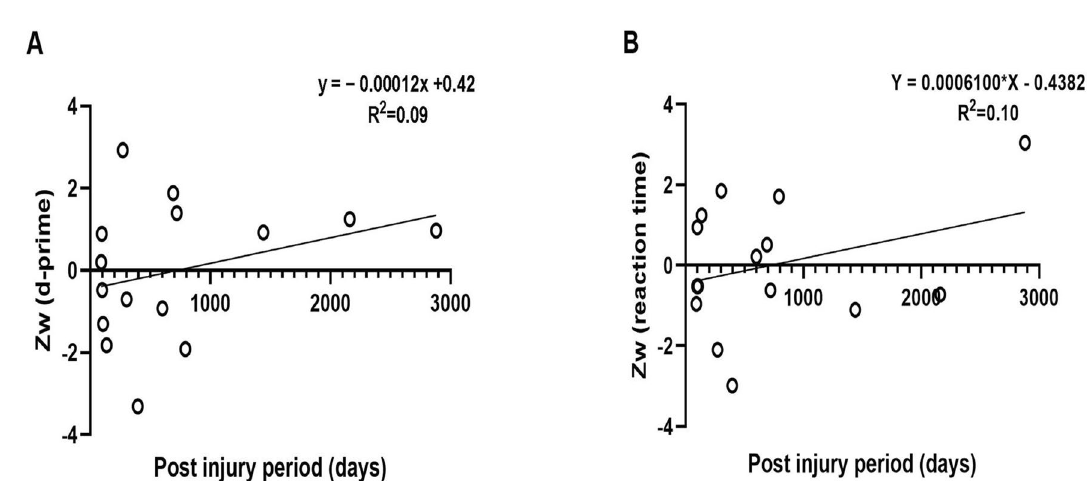
Figure 6. A linear regression analysis between the overall MOT performance (sensitivity and reaction time) as measured by weight-averaged Z-scores and post-injury periods. The solid line represents the line of best